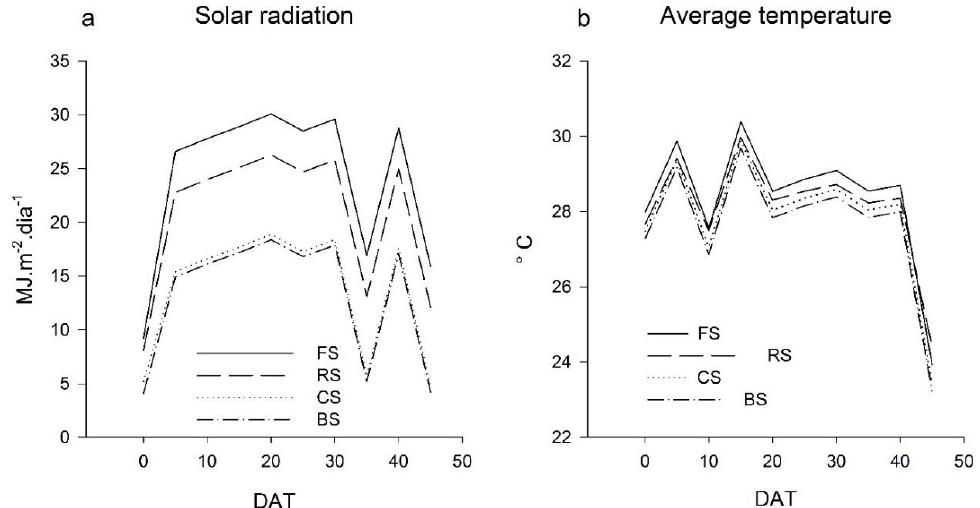
Figure 1. Global solar radiation ( a ), in MJ · m − 2 · day − 1 , and average temperature ( b ), in ◦ C, in full sun (FS) and shaded environments with the red screen (RS), ChromatiNet ® screen (CS), and black screen (BS). DAT, days after transplanting. Figure 2 shows the distribution of spectral radiation under the three studied covers. Among the shades, the highest infrared radiation (IR) transmittance occurred in the envi- ronment covered with a red screen (42.72%), followed by ChromatiNet ® screen (28.69%), and the lowest IR in the environment with a black screen (28.39%). While the highest transmittance of ultraviolet radiation occurred on ChromatiNet ® (5.91%) and the lowest on red screen (4.98%). For photosynthetically active radiation transmittance, the highest value was observed in the environment with red screen (42.72%), followed by Chroma- tiNet ® screen (28.69%) and black screen (28.39%).